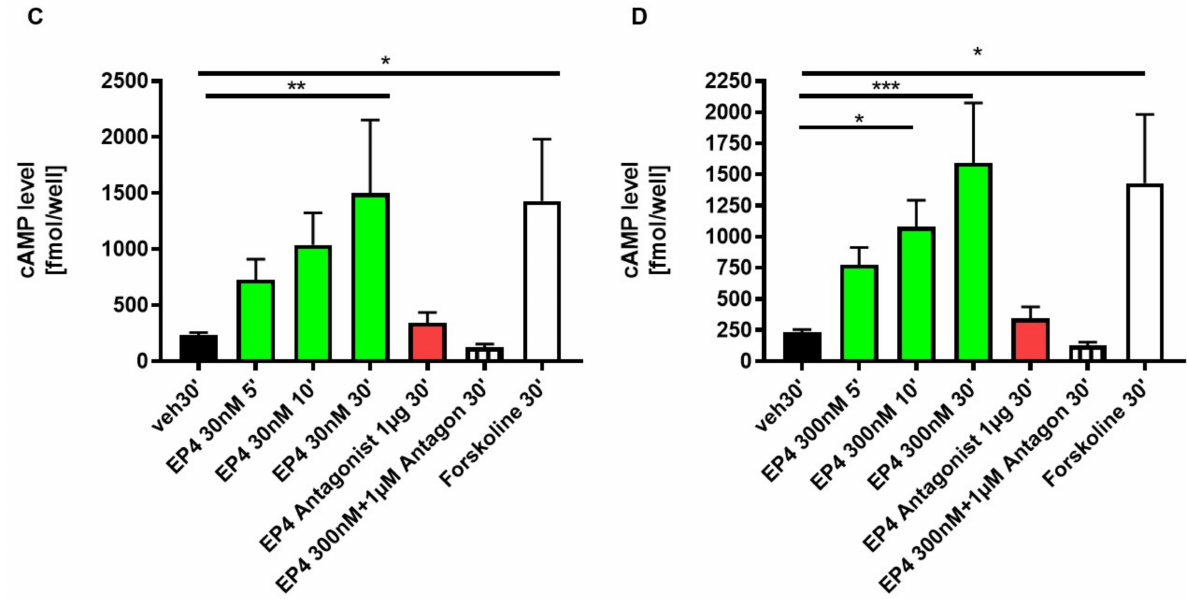
Figure 7. EP4 stimulation of DCTs with ONO AE1-329 (30 nmol/L or 300 nmol/L) significantly increased cAMP production DCTs. Cells were treated with either PGE2 30 nmol/L ( A ) or 300 nmol/L ( B ), EP4 antagonist ONO AE3-208 (1000 nmol/L), or EP4 agonist ONO AE1-329 30 nmol/L ( C ) or 300 nmol/L ( D ). As a control, cells were either not treated (veh) or as a positive control with Forskoline (FSK). Cells were lysed, followed by a 5-, 10- or 30-min incubation before assay. Experiments were performed in duplicates. In total, at least five different experiments were performed. Statistical significances are provided compared to vehicle (* p ≤ 0.05, ** p ≤ 0.01, *** p ≤